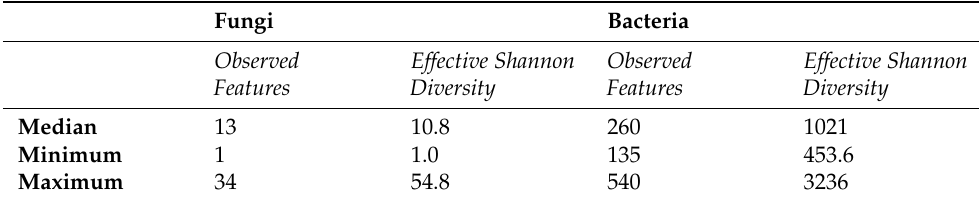
Table 4. Alpha ‐ Diversity of fungal and bacterial communities in the intervention period. Table 4. Alpha-Diversity of fungal and bacterial communities in the intervention period. Fungi